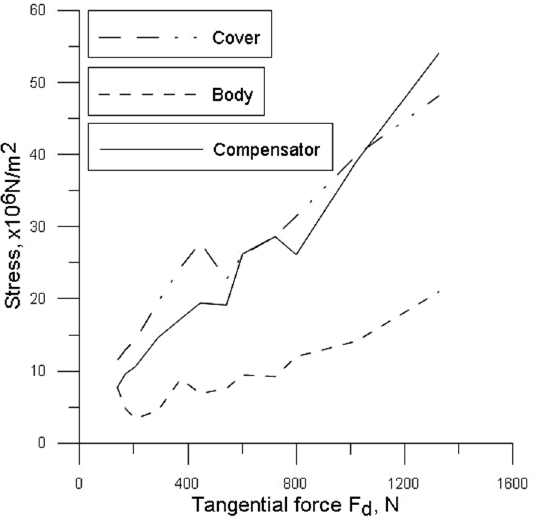
Figure 10. Stress evolution in the two gears, depending on the applied F d forces .